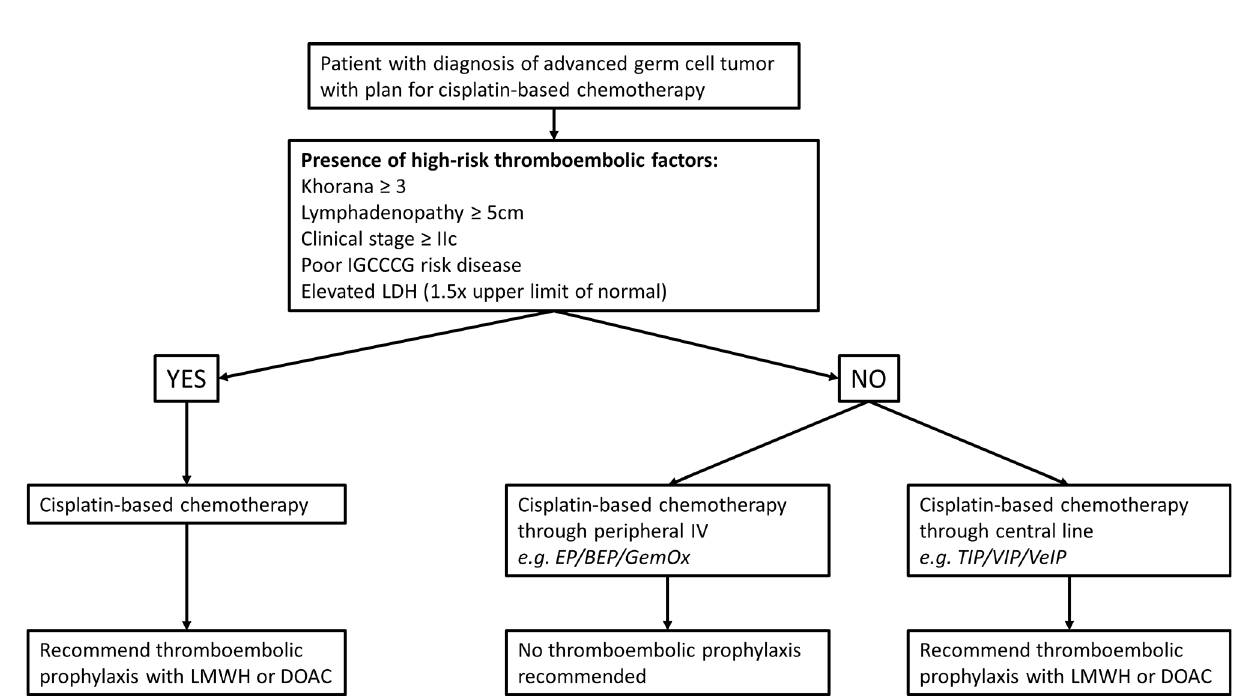
FIGURE 2 | Thromboembolic event prophylaxis fl